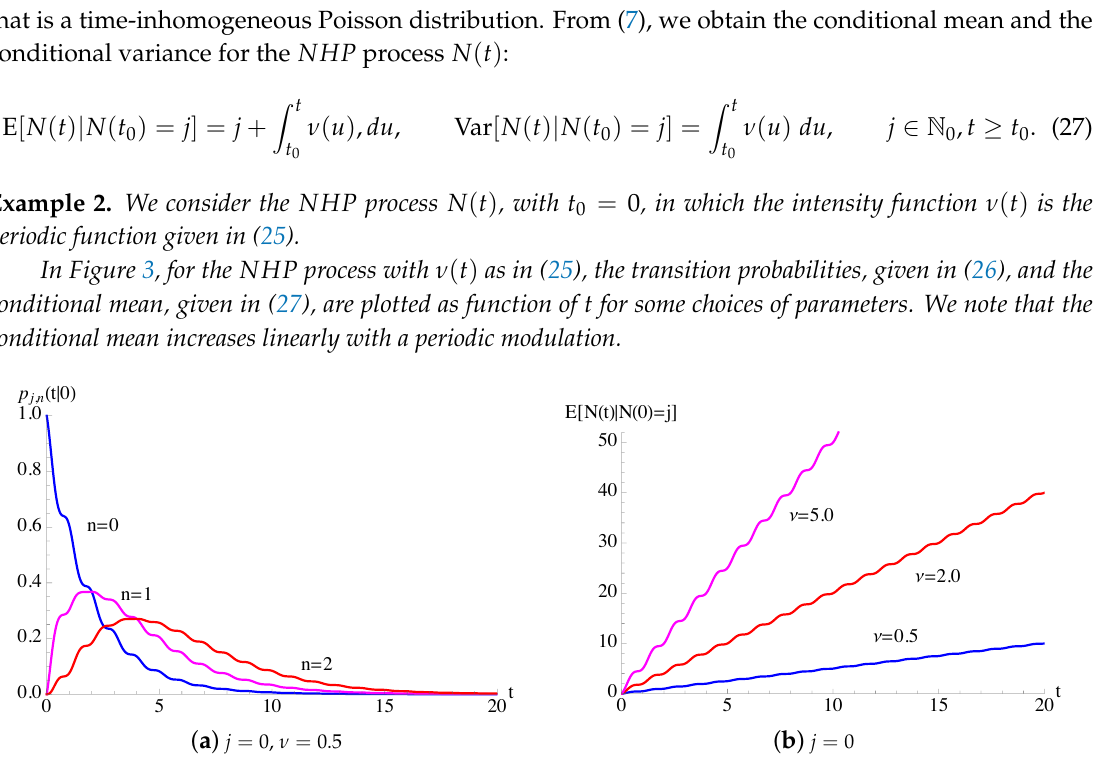
Figure 3. For the time-inhomogeneous Poisson ( NHP ) process, with ν ( t ) given in (25), the probabilities p j , n ( t | 0 ) ( a ) and the conditional mean ( b ) are plotted as function of t for a = 0.9, Q =